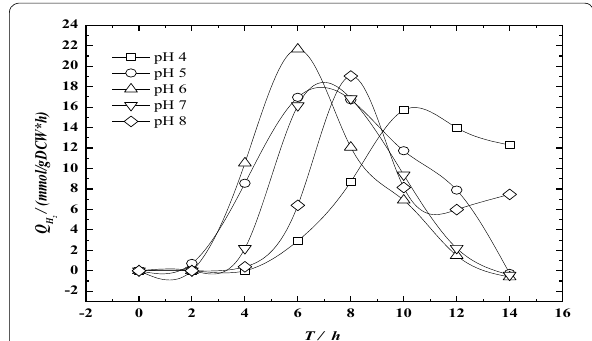
Fig. 10 The effect of different initial pH values on Q H2 by EB-06 glycerol fermentation